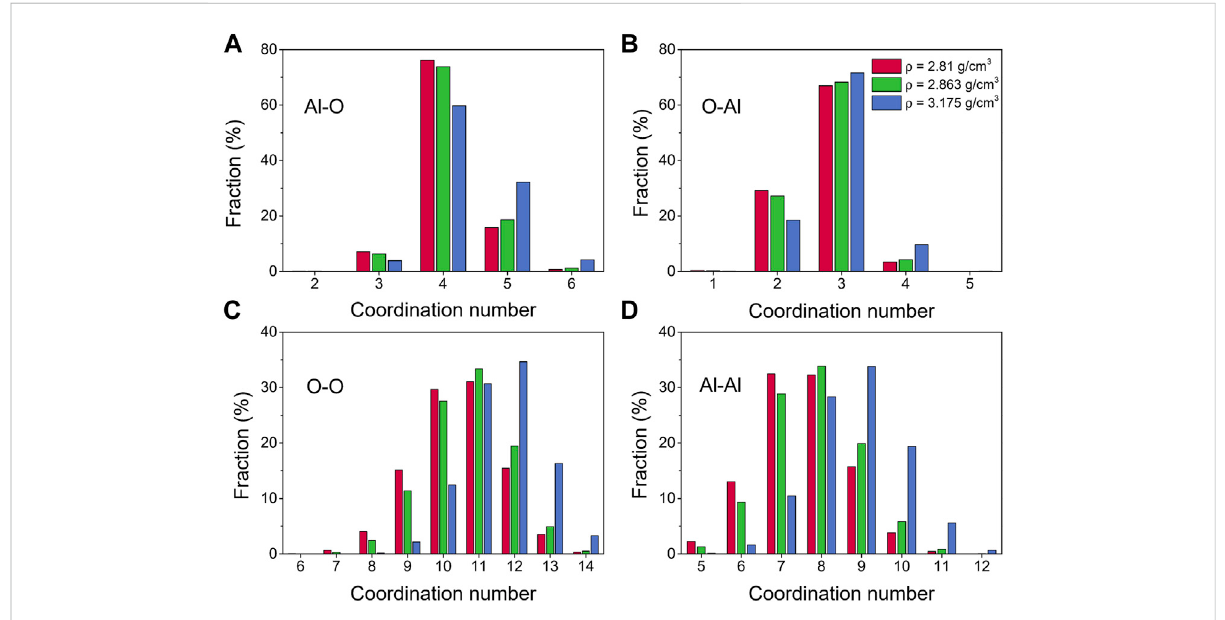
FIGURE 5 Coordination number distributions for liquid alumina at 2500 K and three densities, (A) Al-O, (B) O-Al, (C) O-O and (D) Al-Al.